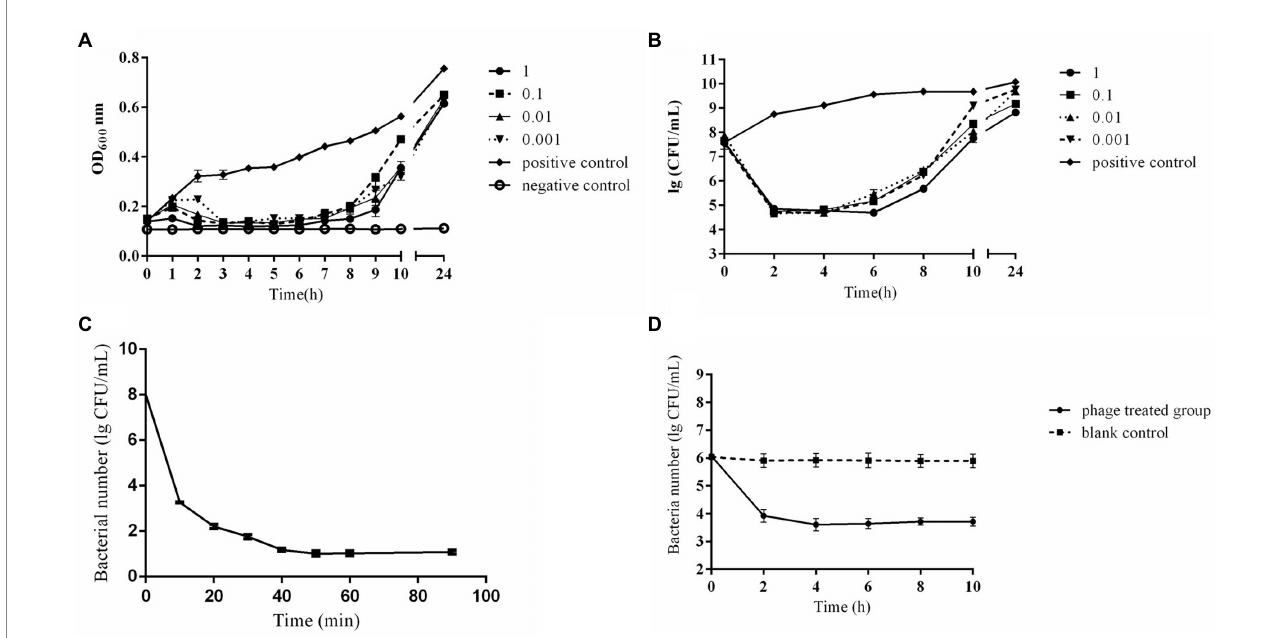
FIGURE 3 In vitro bactericidal activity of phage CE1. Detection of OD 600 from phage CE1 against APEC strain SD-C888 under different MOIs (1, 0.1, 0.01, 0.001) (A) ; Detection of CFUs from phage CE1 against APEC strain SD-C888 under different MOIs (1, 0.1, 0.01, 0.001) (B) ; Detection of bactericidal activity in the spray disinfection (C) ; Detection of bactericidal activity in water disinfection (D) . All data were expressed as means ± SD (n =